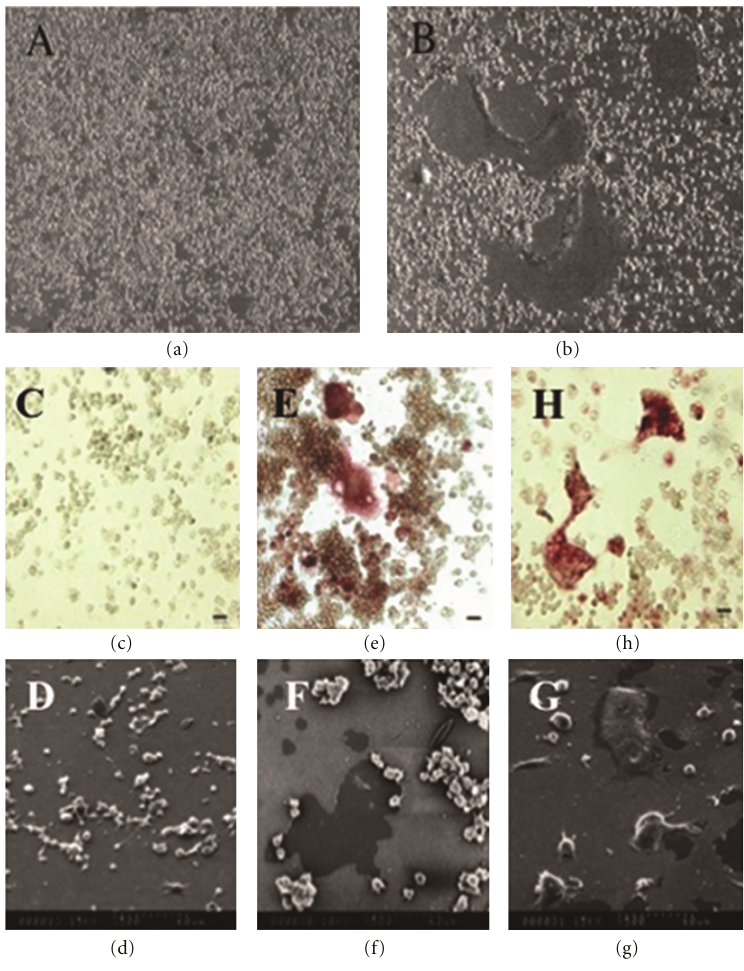
Figure 10: (a) and (b) Cell morphology of mouse macrophages in the presence of LPS Cells images were taken by phase contrast microscope (original magnification, × 10). mMO (RAW 264.7) were cultured for 7days in the absence of LPS (a) and in the presence of 1 μ g/mL LPS (b). (c) to (g) Osteoclast-like cells in RAW264.7 cultures induced by LPS and RANKL mMO (RAW 264.7) were incubated with 1 μ g/mL of LPS or 200ng/mL of RANKL for 7 days. TRAP staining images were taken by phase contrast microscope (c, e and h). Pit formation activity of osteoclasts was observed by SEM (d, f and g). (c and d) mMO seeded on CaP substrate (control), (e and f) treated with LPS and (h and g) treated with